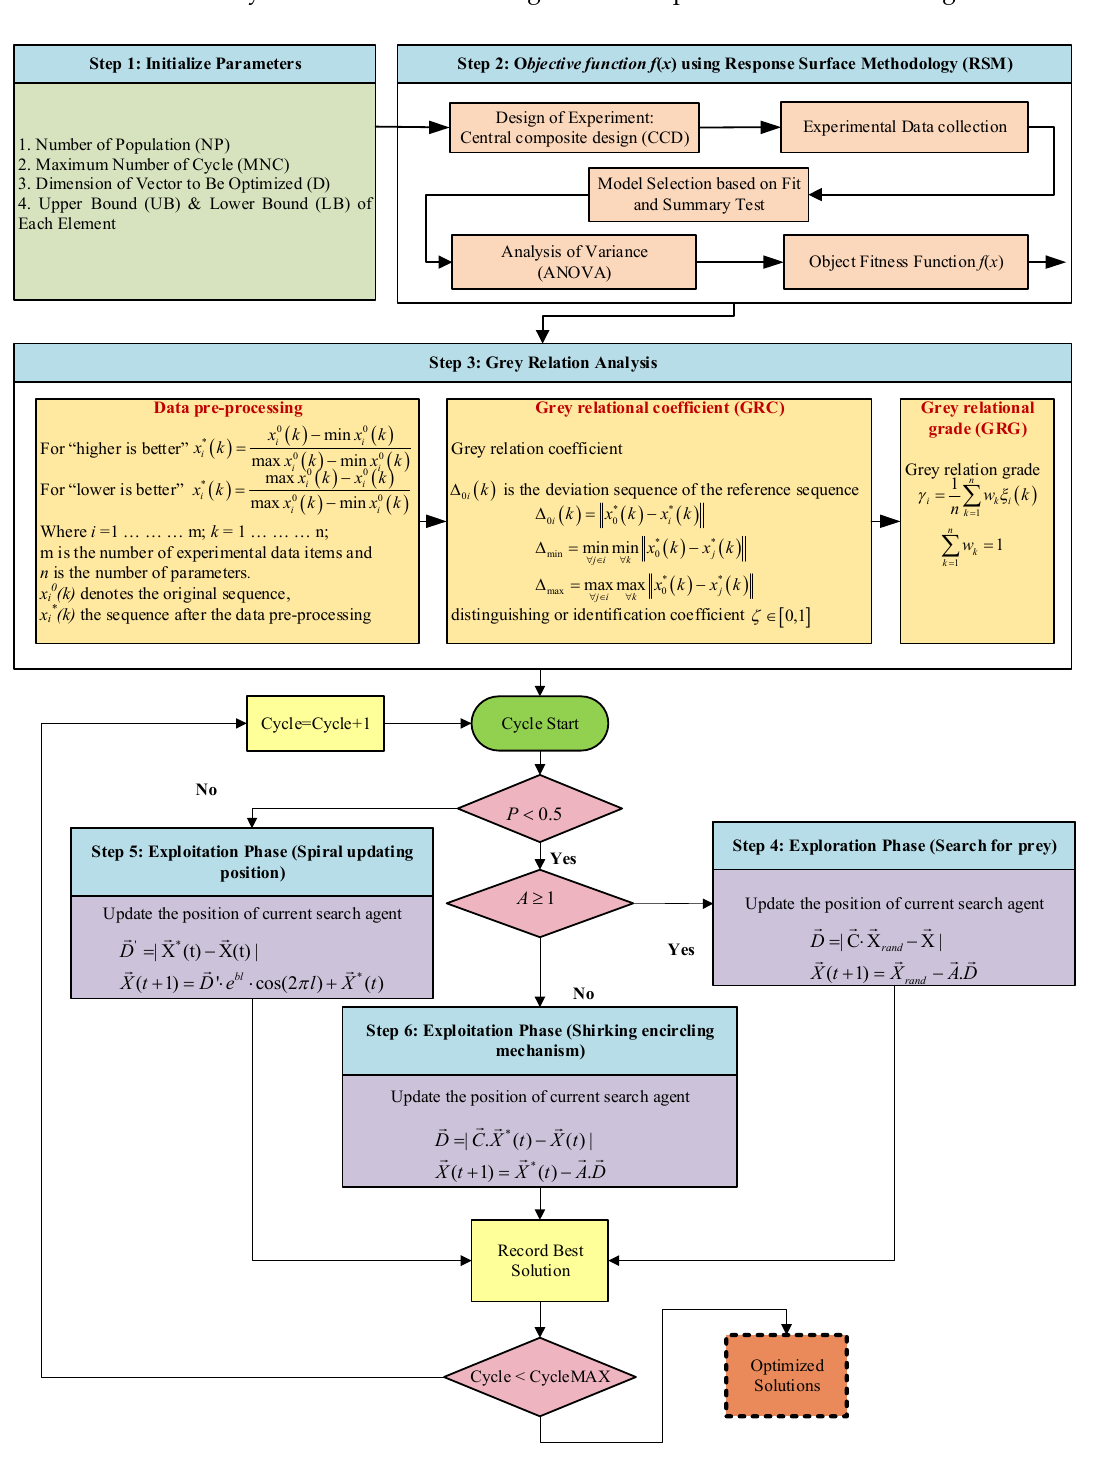
Figure 1. Flow Diagram of the hybridized whale-grey, multi-objective algorithm.